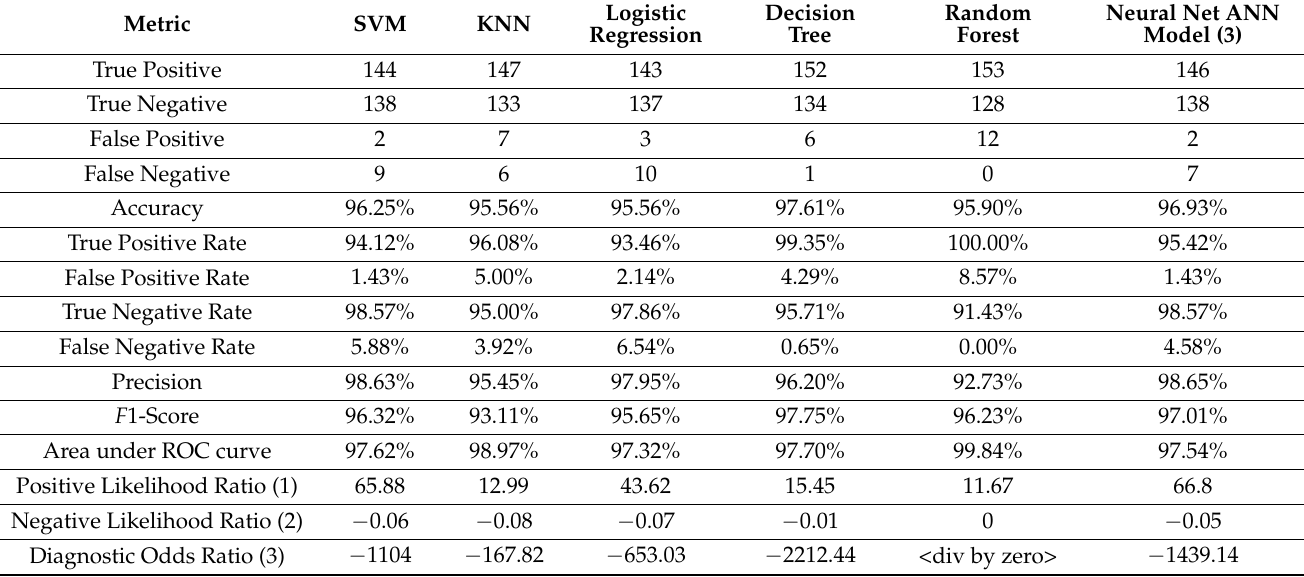
Table 3. Comparison of metrics for different